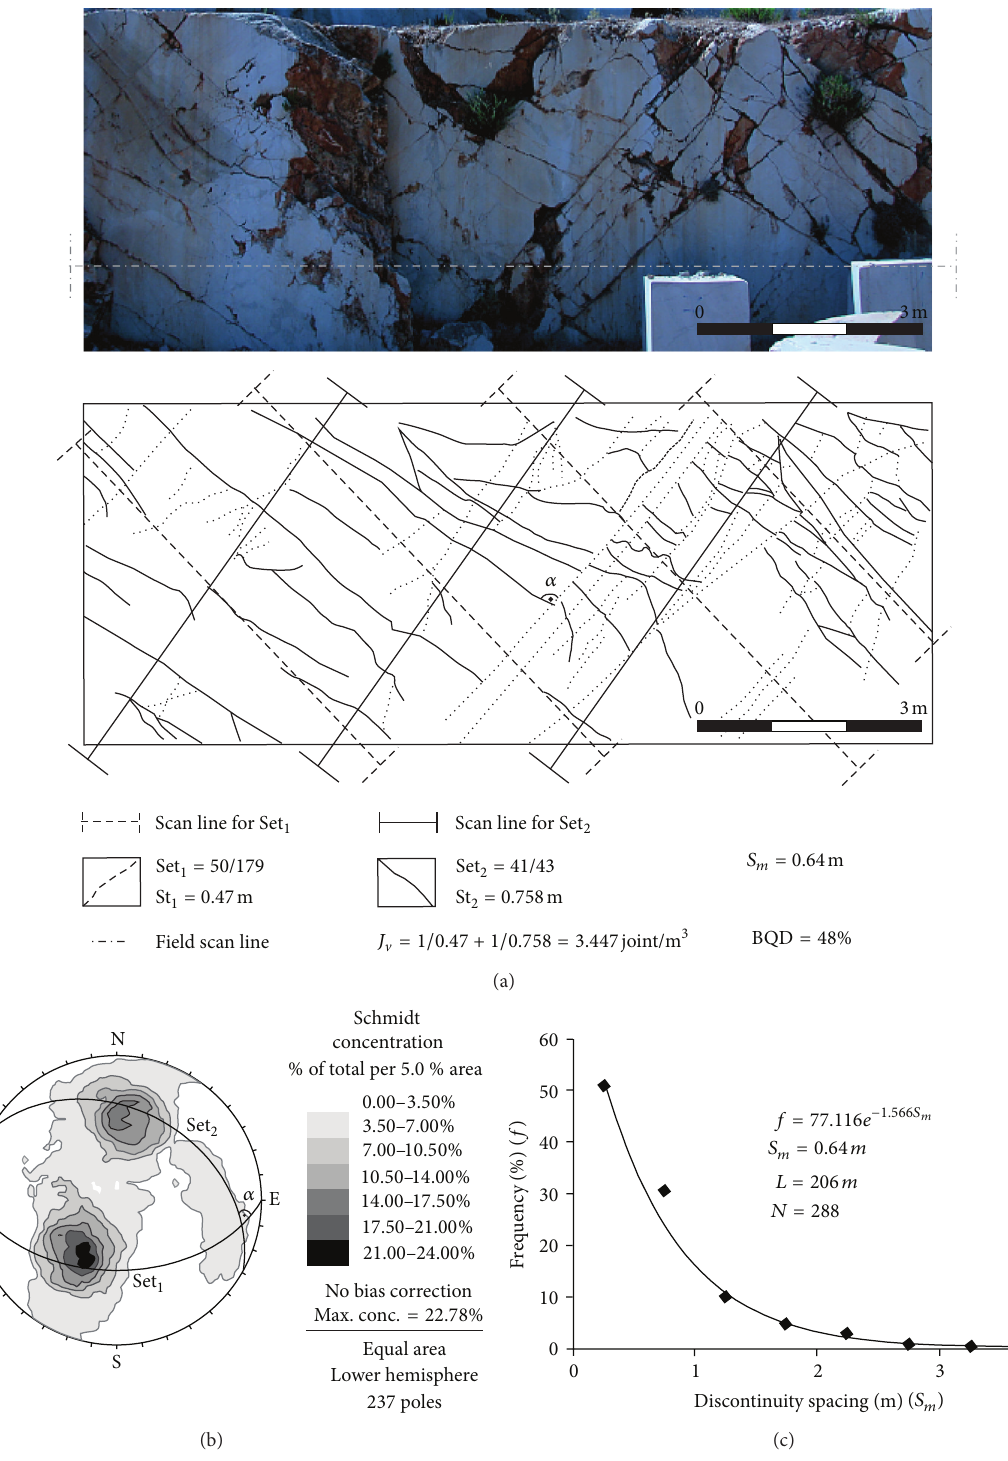
Figure 4: (a) A panoramic view and a section of 1/100 scale discontinuity trace map of a part of the quarry 8. (b) Lower hemispherical stereographic projection plots of the discontinuity traces in quarry 8. (c) Negative exponential distribution is found to fit into the discontinuity spacing data obtained along the horizontal trace line